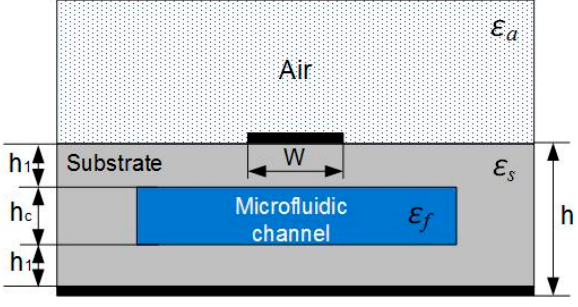
Figure 3. Cross section of the proposed sensor.